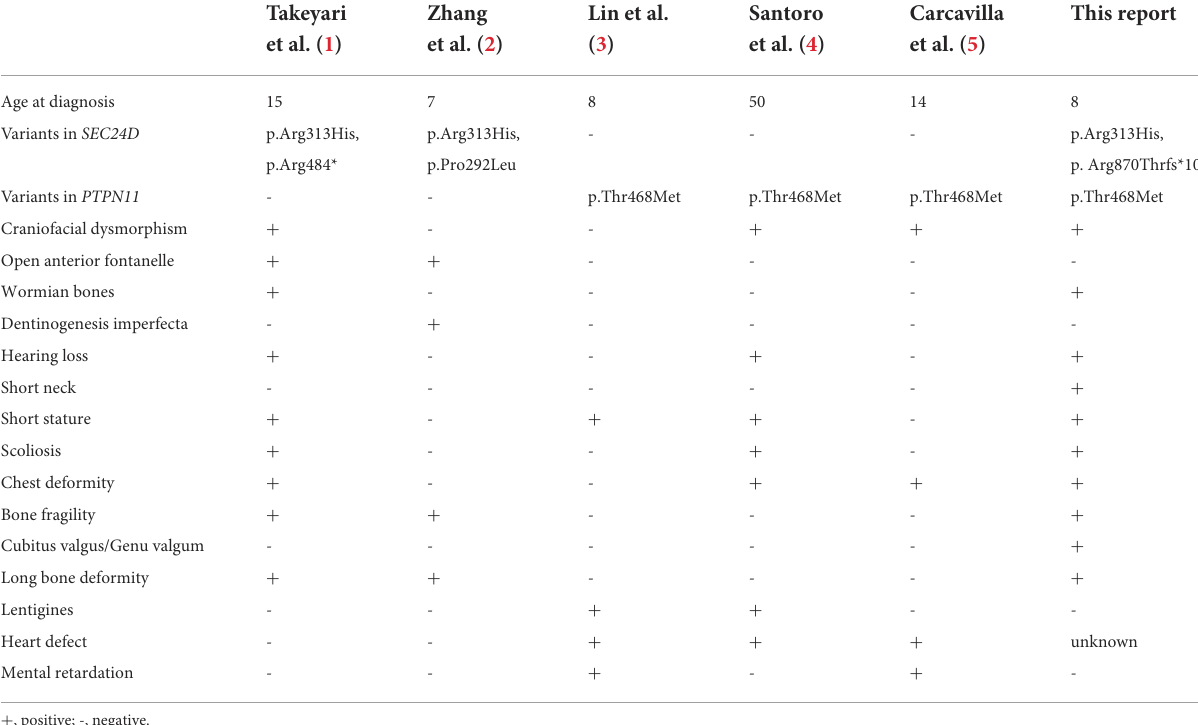
TABLE 1 Clinical features of patients with similar molecular diagnosis to our patient.